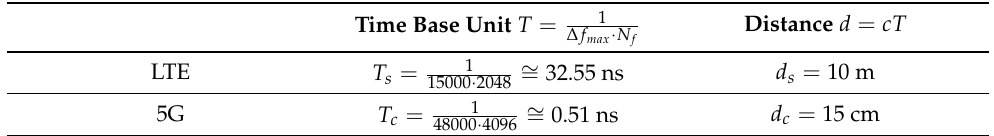
Table 1. Comparison between the time base units (required to represent the time domain) of LTE and new radio (5G) technologies. We refer to the LTE time base unit as T s and to 5G’s as T c . The second column reports Ts and Tc in seconds, and in the third, they are converted into meters. ∆ f max is the subcarrier spacing (SCS), and N f is the number of Fourier points. Time Base Unit T